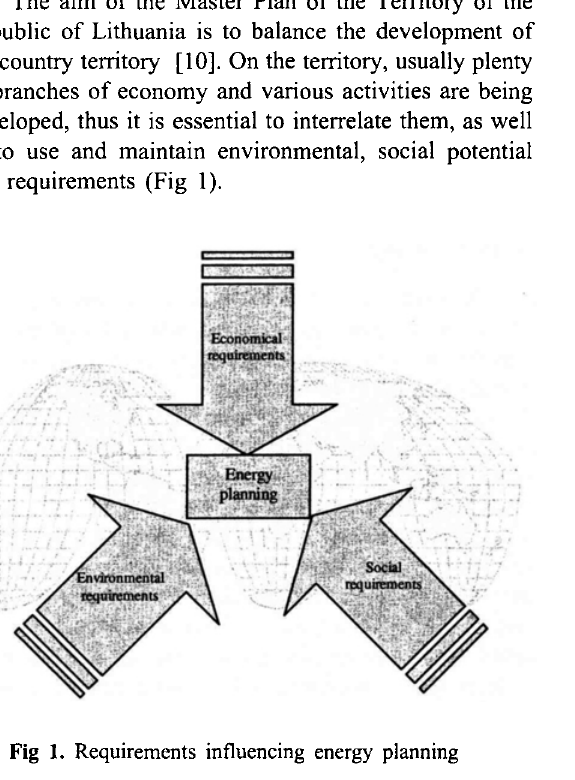
Fig I. Requirements influencing energy